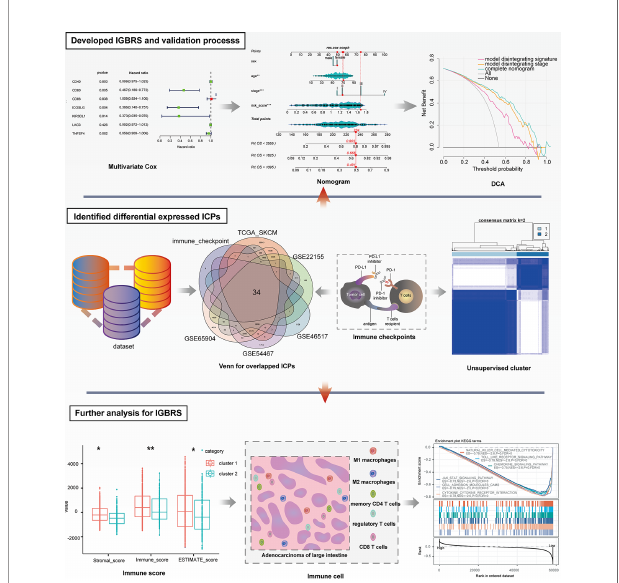
FIGURE 1 | The entire analytical process of the